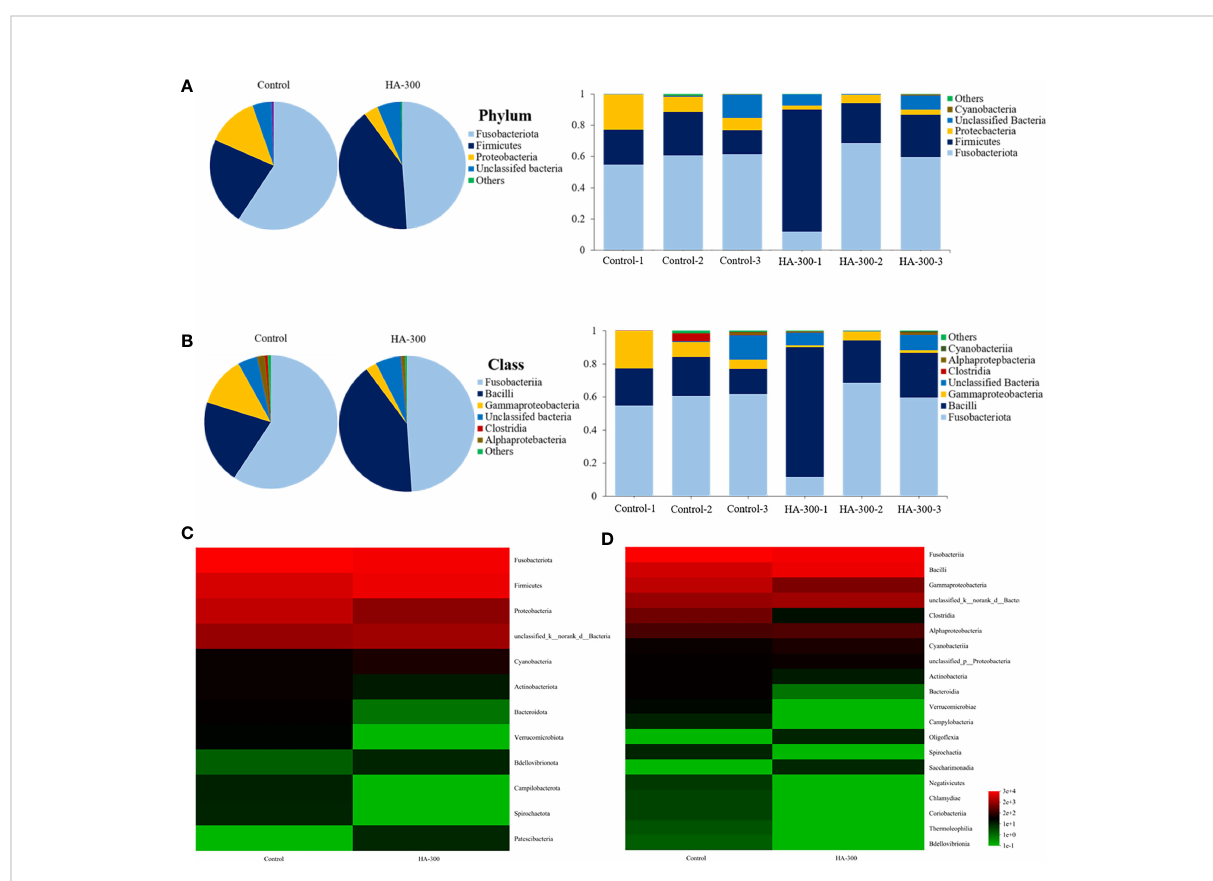
FIGURE 4 Comparisons of the intestinal micro fl ora structure at the phylum and class levels of largemouth bass (n = 3). (A) Percentage distribution and relative abundance of intestinal micro fl ora at the phylum level. (B) Percentage distribution and relative abundance of intestinal micro fl ora at the class level. (C, D) Heatmap of intestinal micro fl ora abundance at the phylum and class